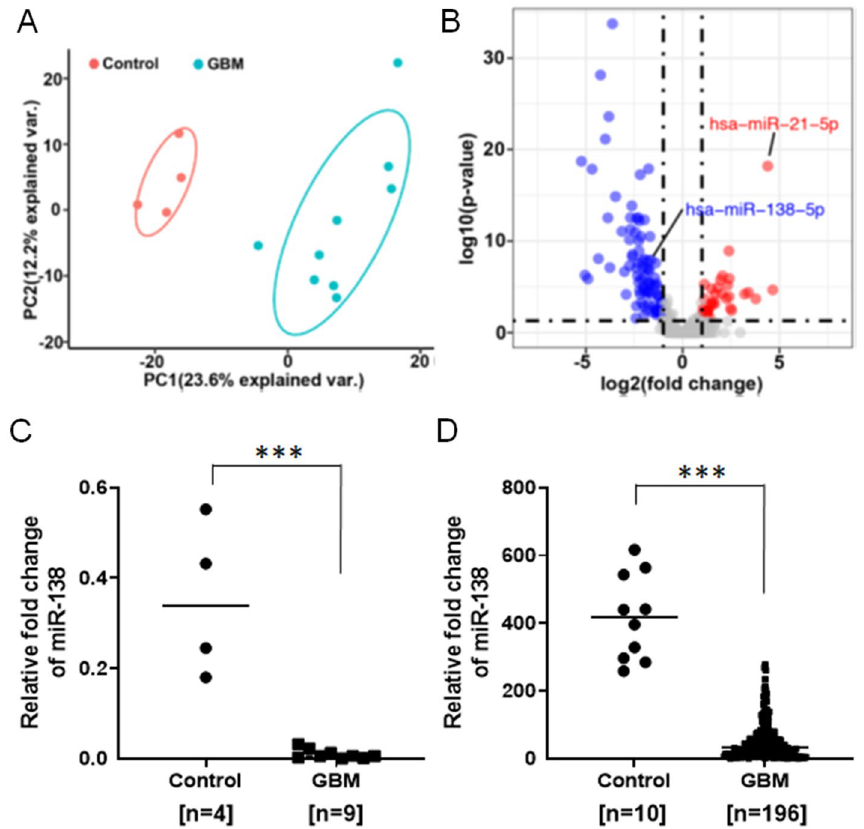
Figure 1. Downregulation of miR-138 in glioblastoma (GBM) patient specimens. ( A ) Principal component analyses (PCA) on miRNA expression profiling obtained by NanoString miRNA Expression Analysis from 9 GBM patients and 4 negative control samples. As a quality control, PCA plot clearly classified the samples into two groups. ( B ) Volcano plot reveals down-regulation of miR-138 in an inverse correlation with miR-21. ( C ) Expression of miR-138 in GBM samples (0.009915 ± 0.003592, n = 9) compared to negative control samples (0.3525 ± 0.08532, n = 4) analyzed by qRT-PCR using TaqMan individual miRNA assay. ( D ) The Cancer Genome Atlas Program (TCGA) database shows that miR-138 expression is downregulated in glioblastoma (GBM) compared to normal tissues. All error bars indicates standard deviations, and Student t -test was used to determine the significance in difference between the two groups. *** p <